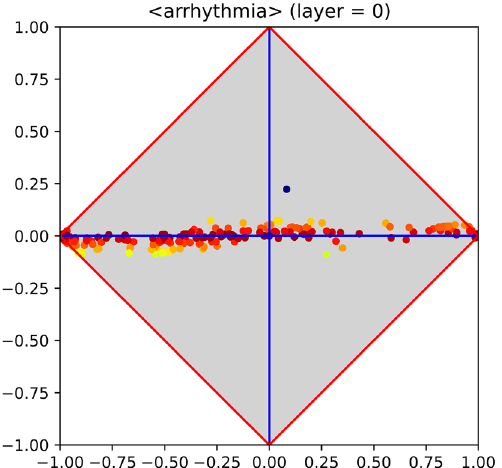
Figure 5. Class signature of the arrhythmia dataset (from UCI). The problem is expected to be difficult, as almost all features lay in proximity of the ϕ axis; the only exception being the blue point at the upper-right part of the diagram, which shows a small, but not negligible, correlation with the occurrence of arrhythmia. Besides, that point corresponds to the binary feature sex ={M,F}, which is in accordance with the existing statistics about this disease.